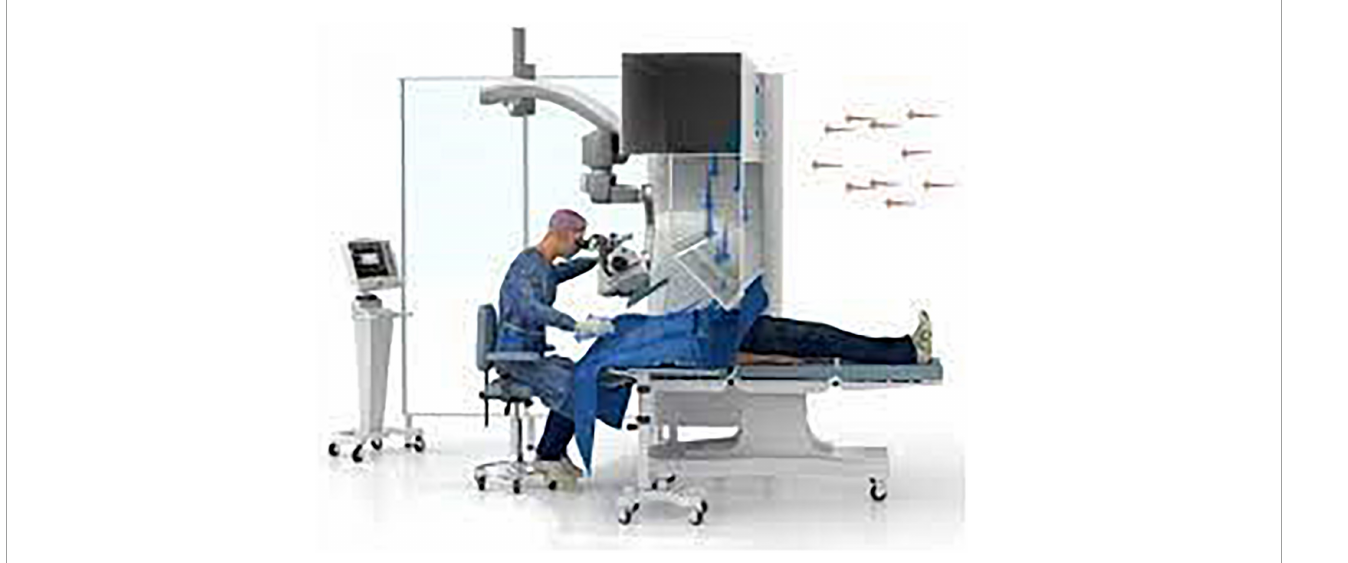
FIGURE1 Surgicube: A mobile operation theater system.